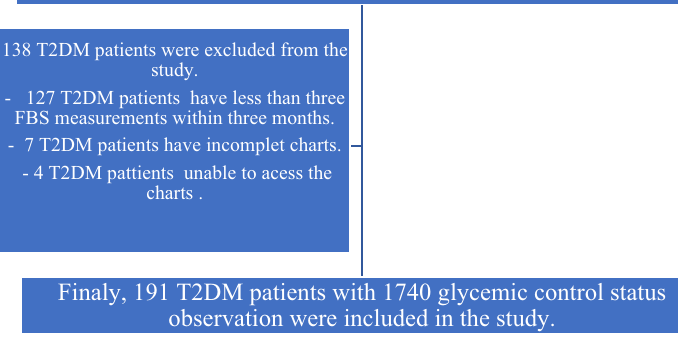
Figure 2. Summary of study participants recruiting flow